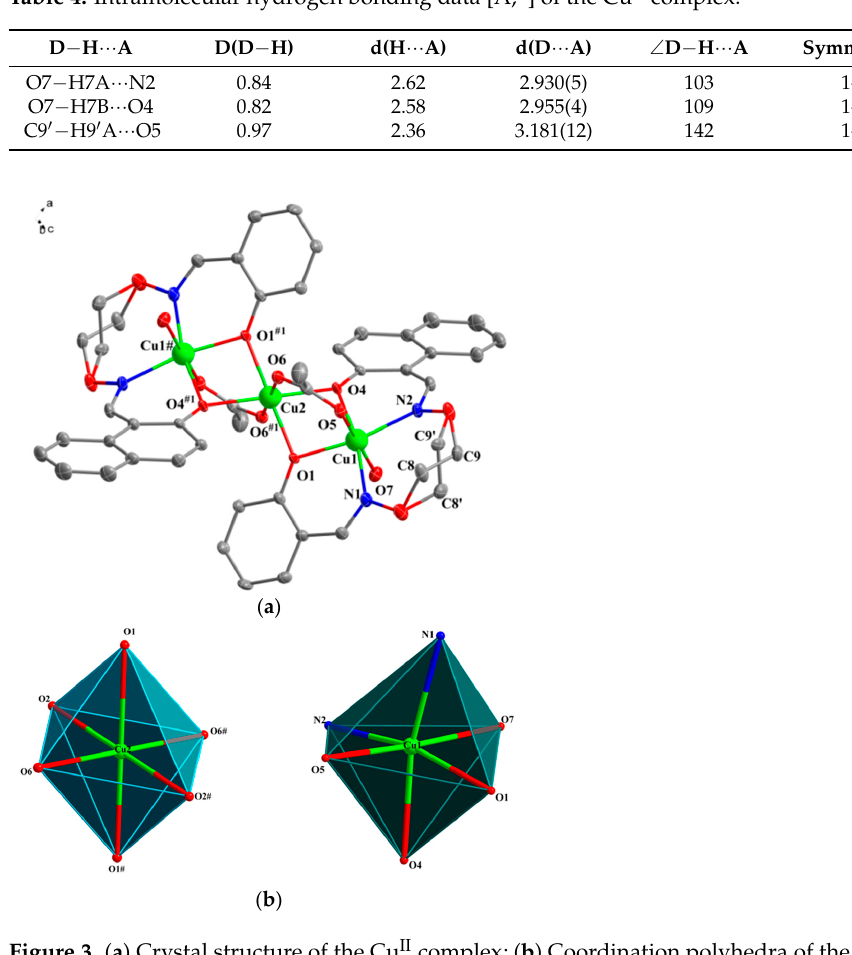
3.4. Molecular Simulation Calculation of H 2 L and Its Cu II Complex In order to better investigate the structures of H 2 L and its Cu II complex, the DMol 3 module of MS (Materials Studio) software was used to optimize and simulate the mole- cules of H 2 L and its Cu II complex [60]. The method of structural optimization (property calculation) is GGA, BP (PBE) with the base set DND (DNP), the solvent model (ethanol), the optimization precision set me- dium, and smooth thermal smearing to speed up the convergence of structural optimiza- tion. The molecule energies and frontier molecular orbital energies of H 2 L and its Cu II complex are shown in Table 5. For H 2 L, it could be found that the calculated energy gap between the LUMO and HOMO of the Cu II complex (0.984 ev) is lower than that of H 2 L (1.803 ev) (Figure 5). According to the frontier orbital theory, the photoinduced electron transfer (PET) may be caused by fluorescence quenching [24].